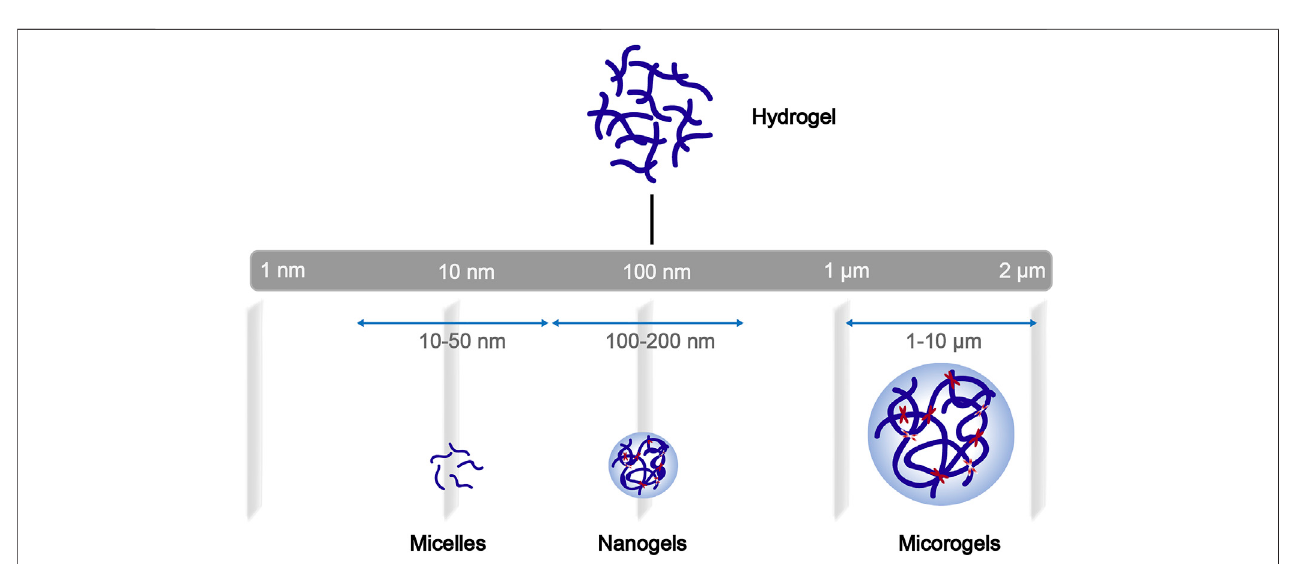
FIGURE 1 | General schematization of the network construction of hydrogels and derivatives of different sizes.